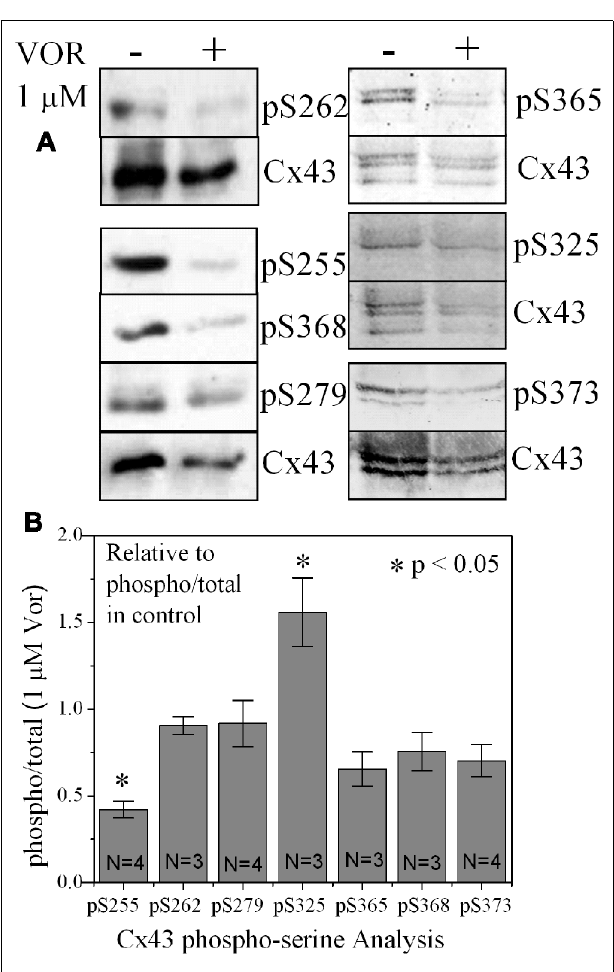
FIGURE 4 |Alteration of Cx43 phosphorylation state by vorinostat. (A) Representative western blot of control and 1 μ MVOR-treated ventricular myocyte lysates detected with Cx43 phospho-serine (pSer) specific anti-pS255, anti-pS262, anti-pS279/282, anti-pS368, anti-pS325/328/330, anti-pS365, and anti-pS373 antibodies.The total Cx43 was also immunoblotted with an anti-Cx43 carboxyl-terminal antibody that recognizes all forms of Cx43. (B) Cx43 phospho-serine pS255, pS262, pS279/282, pS368, pS325/328/330, pS365, and pS373 levels were compared by densitometry to the total Cx43 levels in control and 1 μ M VOR-treated samples to generate the phospho/total Cx43 ratios.The